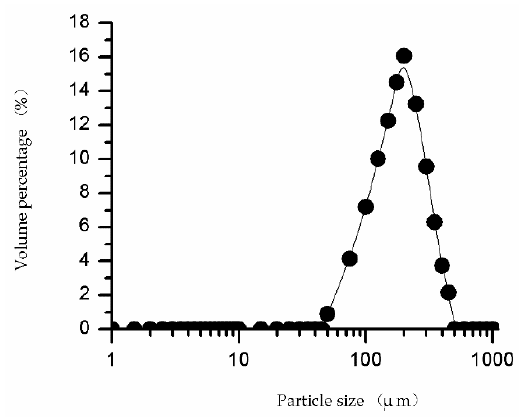
Figure 4. Particle size distribution of SSO-MIPs.